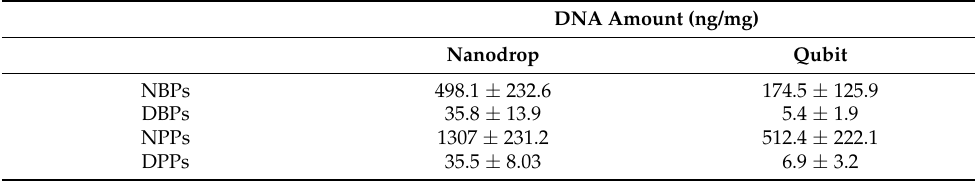
Table 1. DNA quantification in native and decellularized bovine (NBPs and DBPs) and porcine (NPPs and DPPs) pericardia, as measured by the Nanodrop and Qubit assays. Data are expressed as mean ± SD.